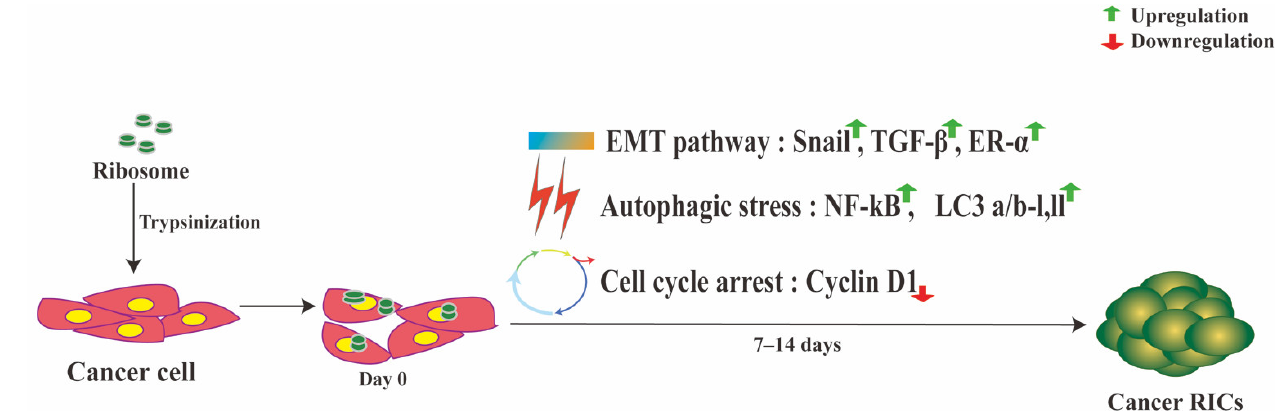
Figure 3. Ribosomes stop cancer cell proliferation through stress.